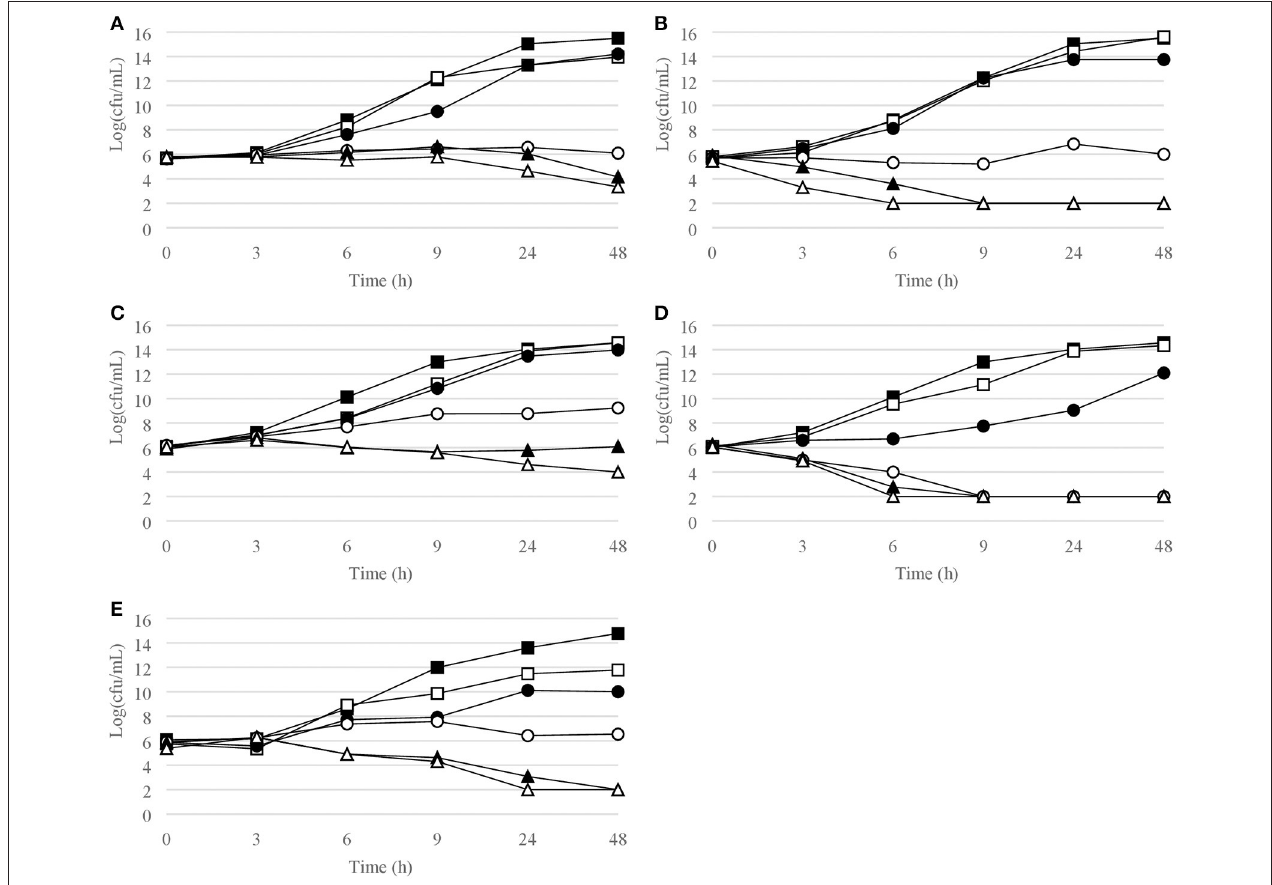
FIGURE 6 | Time-kill curves for enterobacteriaceae. (A) E. coli , chlorquinaldol; (B) E. coli , gentamicin; (C) E. cloacae, chlorquinaldol; (D) E. cloacae , gentamicin; (E) P. mirabilis , chlorquinaldol. Filled square, control; open square, ¼ × MIC; filled circle, ½ × MIC; open circle, 1 × MIC; filled triangle, 2 × MIC; open triangle, 4 ×